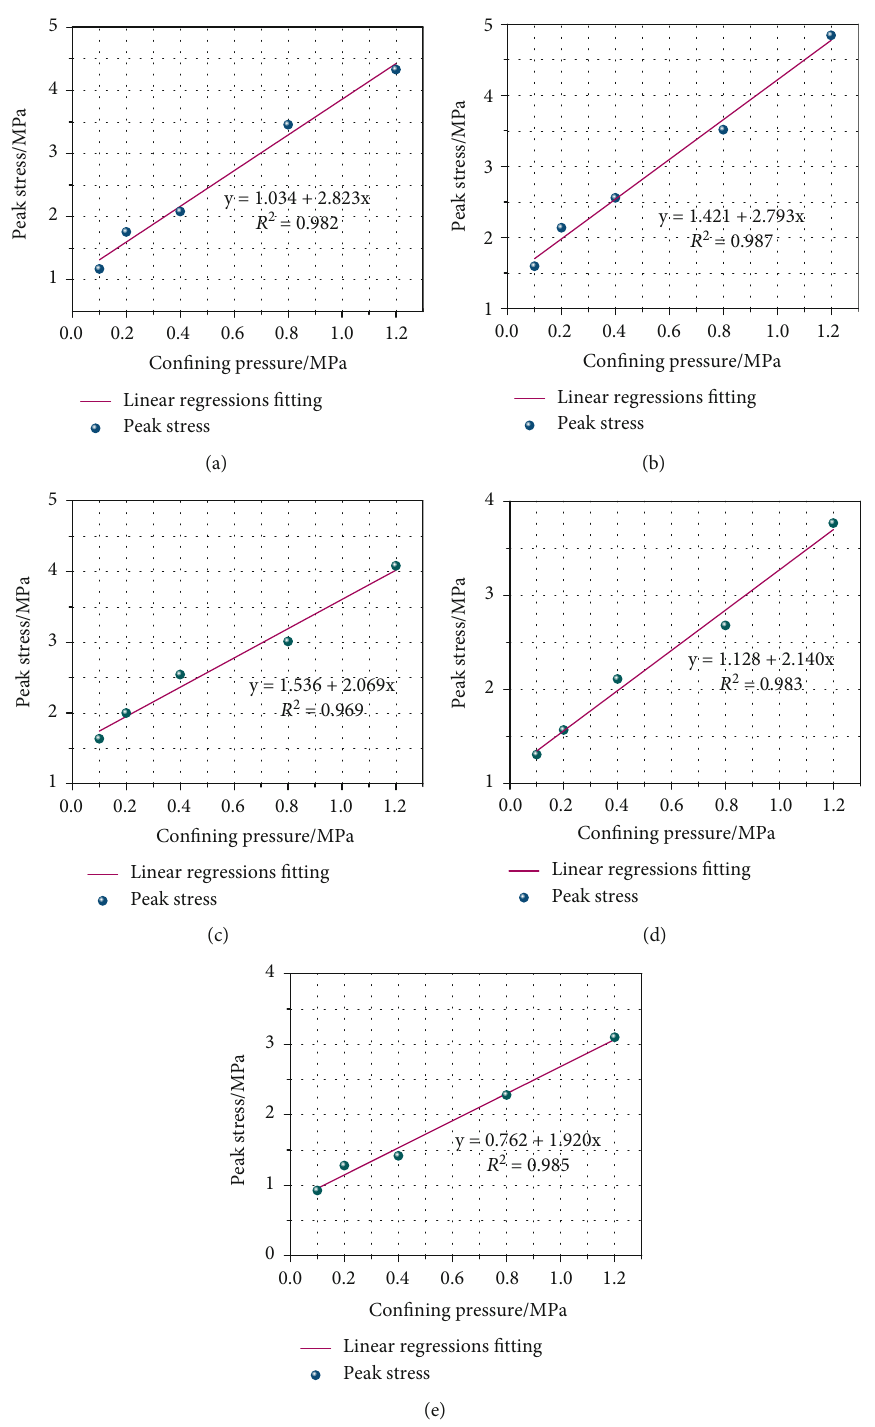
Figure 5: Relationship between stress peak value and con fi ning pressure under di ff erent moisture content conditions. (a) Moisture content 4%. (b) Moisture content 6%. (c) Moisture content 8%. (d) Moisture content 10%. (e) Moisture content